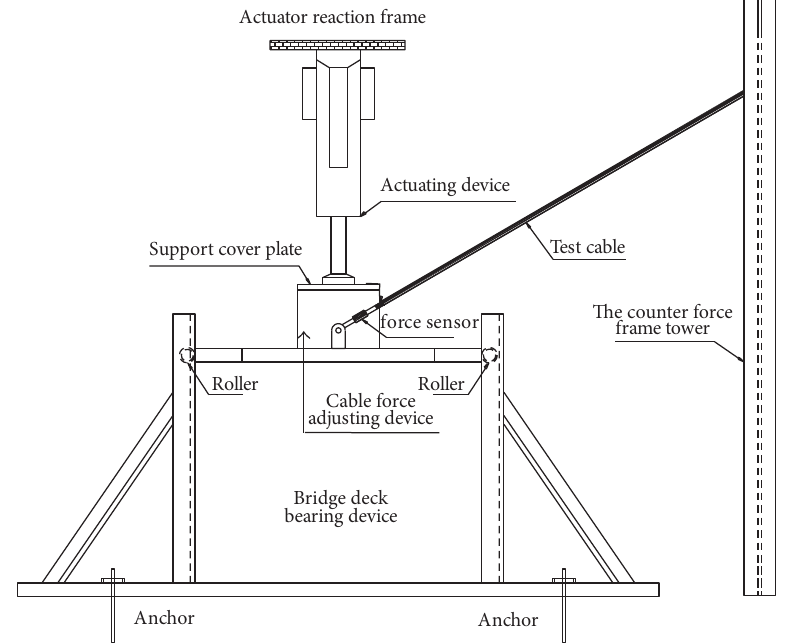
Figure 1: The overall layout of the test model.